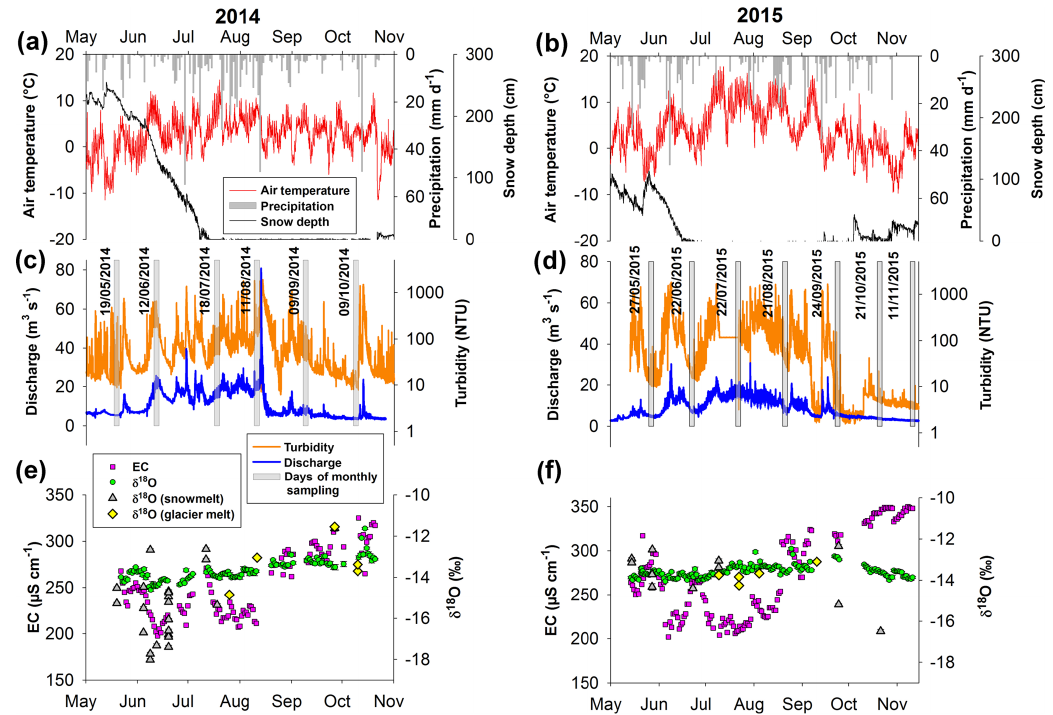
Figure 8. Time series from 2014 and 2015 of (a, b) precipitation, hourly air temperature and snow depth at the AWS Madritsch; (c, d) stream- flow and turbidity; and (e, f) electrical conductivity and δ 18 O of the stream at the outlet Stilfserbrücke and of snowmelt and glacier meltwater. Grey shaded bars indicate the date of monthly sampling carried out in the entire